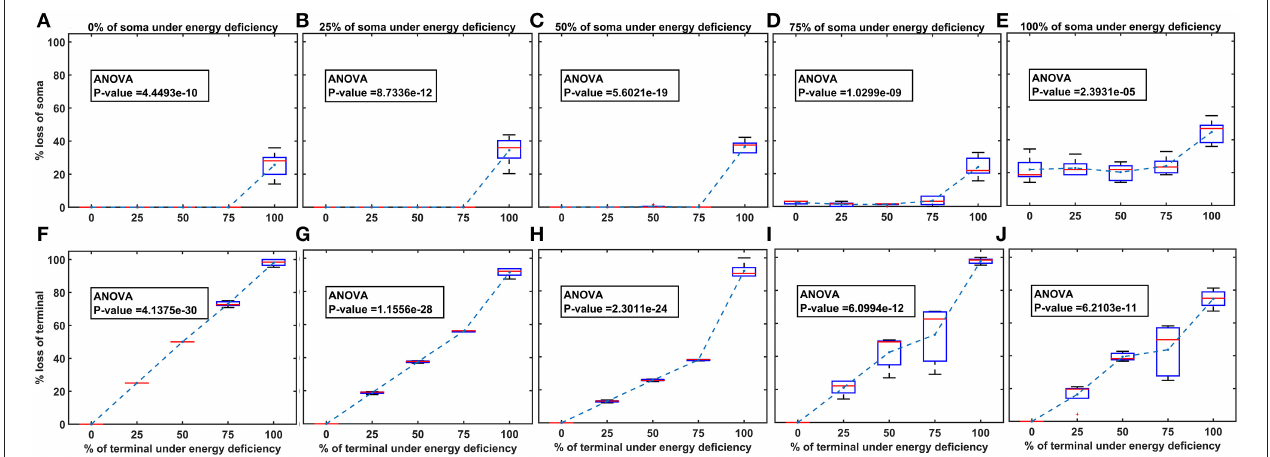
FIGURE 6 | The model response under heterogeneous energy deficiency. (A–E) The percentage loss of SNc somas, (F–J) the percentage loss of SNc terminals. SNc, substantia nigra pars compacta.